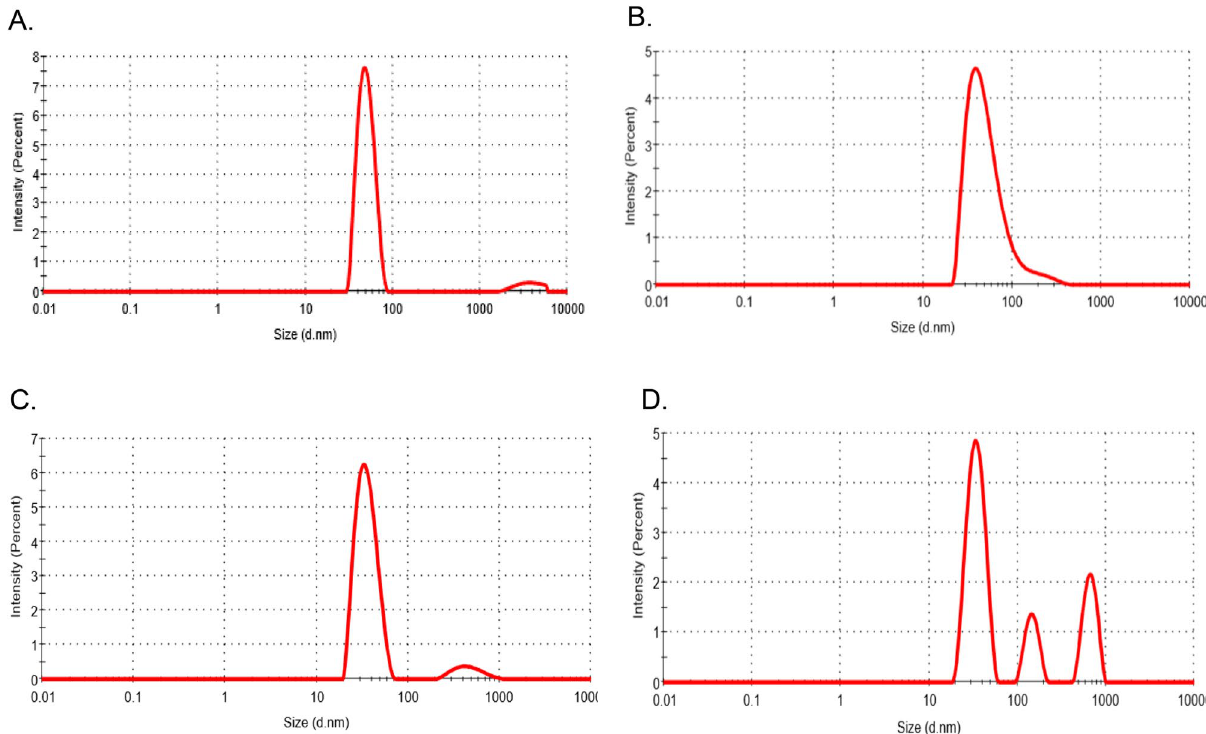
Figure 3. Dynamic-light-scattering distribution curves of AAR. Panel A, B, C, and D represent intensity size distribution curves for AAR GFC pooled fractions a, b, c, and d, respectively, obtained using Malvern Zetasizer software (version 7.12). The concentration of each pooled fraction was 1